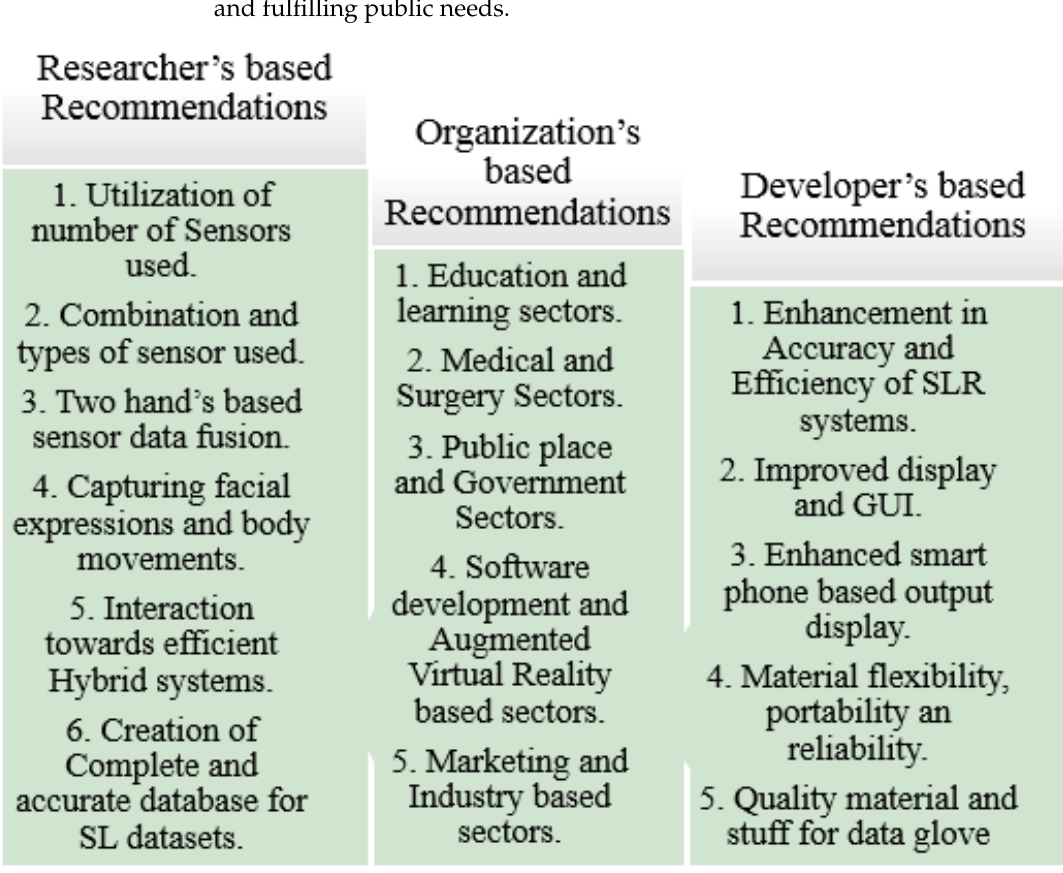
Figure 22. Overview of recommendation domains of the sign language model.